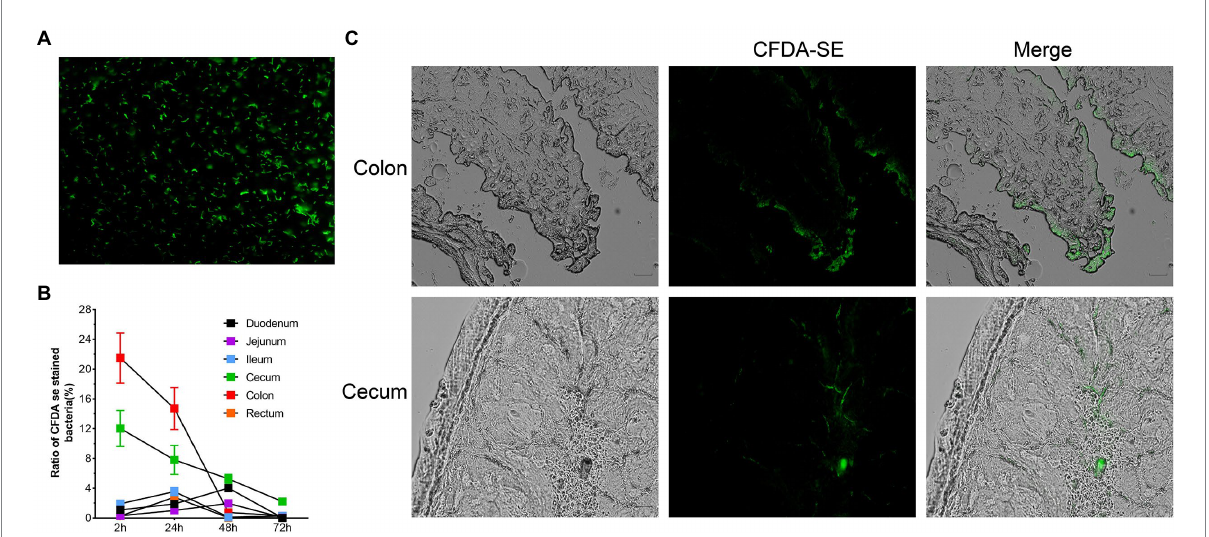
FIGURE 8 Using flow cytometry and frozen sections to characterize the colonization of Roseburia intestinalis in the GIT. (A) CFDA-SE labelled R. intestinalis investigated under fluorescence microscopy. (B) R. intestinalis fluorescence at different time points and in different areas of the intestine. (C) Frozen sections were used to observe the distribution of R. intestinalis in the colon and cecum.